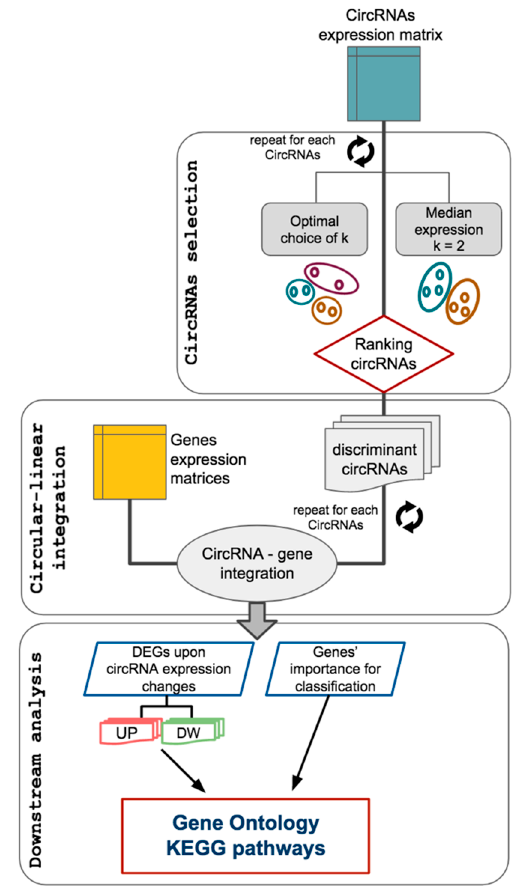
Figure 2. The CircIMPACT workflow.